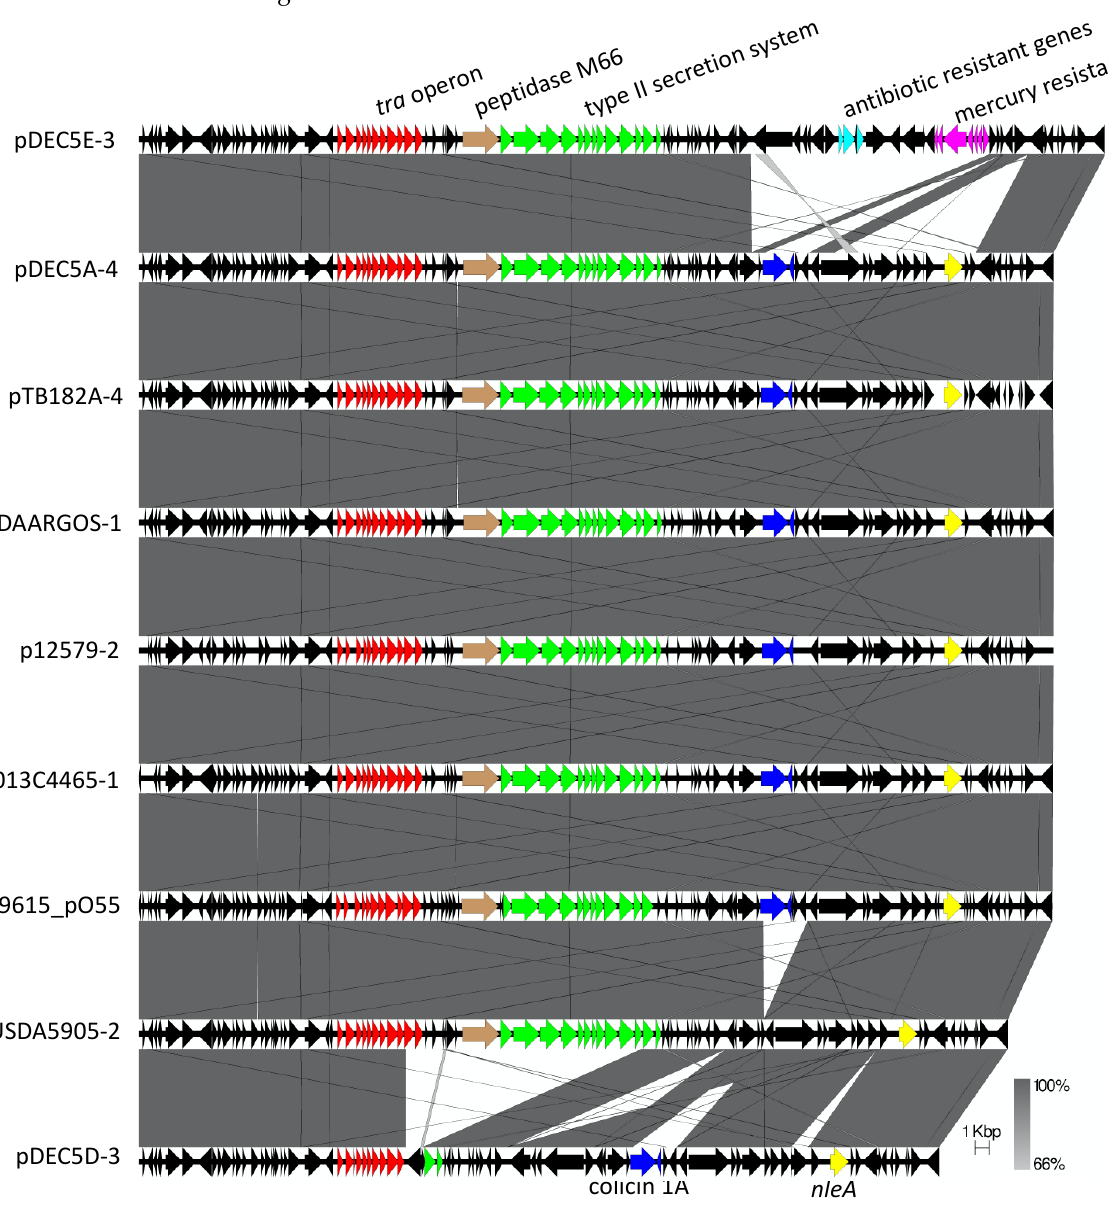
Figure 5. Genetic map showing the O55:H7 57 ‐ kb to 69 ‐ kb plasmid present in 9 of the 10 strains. Each colored arrow represents a different gene or group of genes labeled above or below the genetic map. The black arrows are other genes on the plasmids. The shades of gray between the genetic map represents the percent similarity of the plasmids to each other. The scale bar represents plasmid size in kilobases.